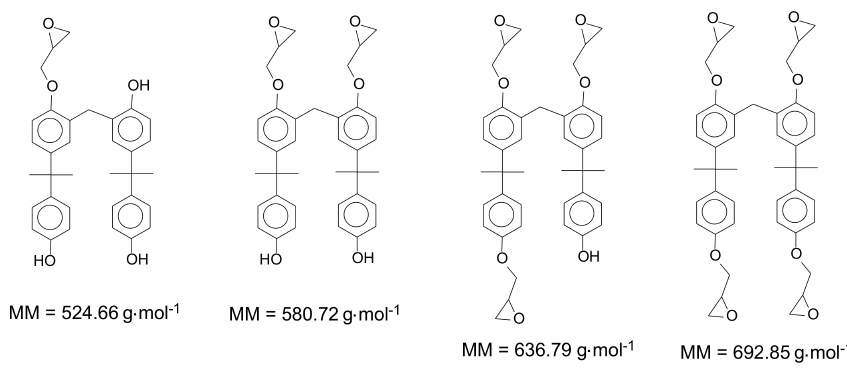
Figure 10. Mass variation in function of the epoxidation degree.